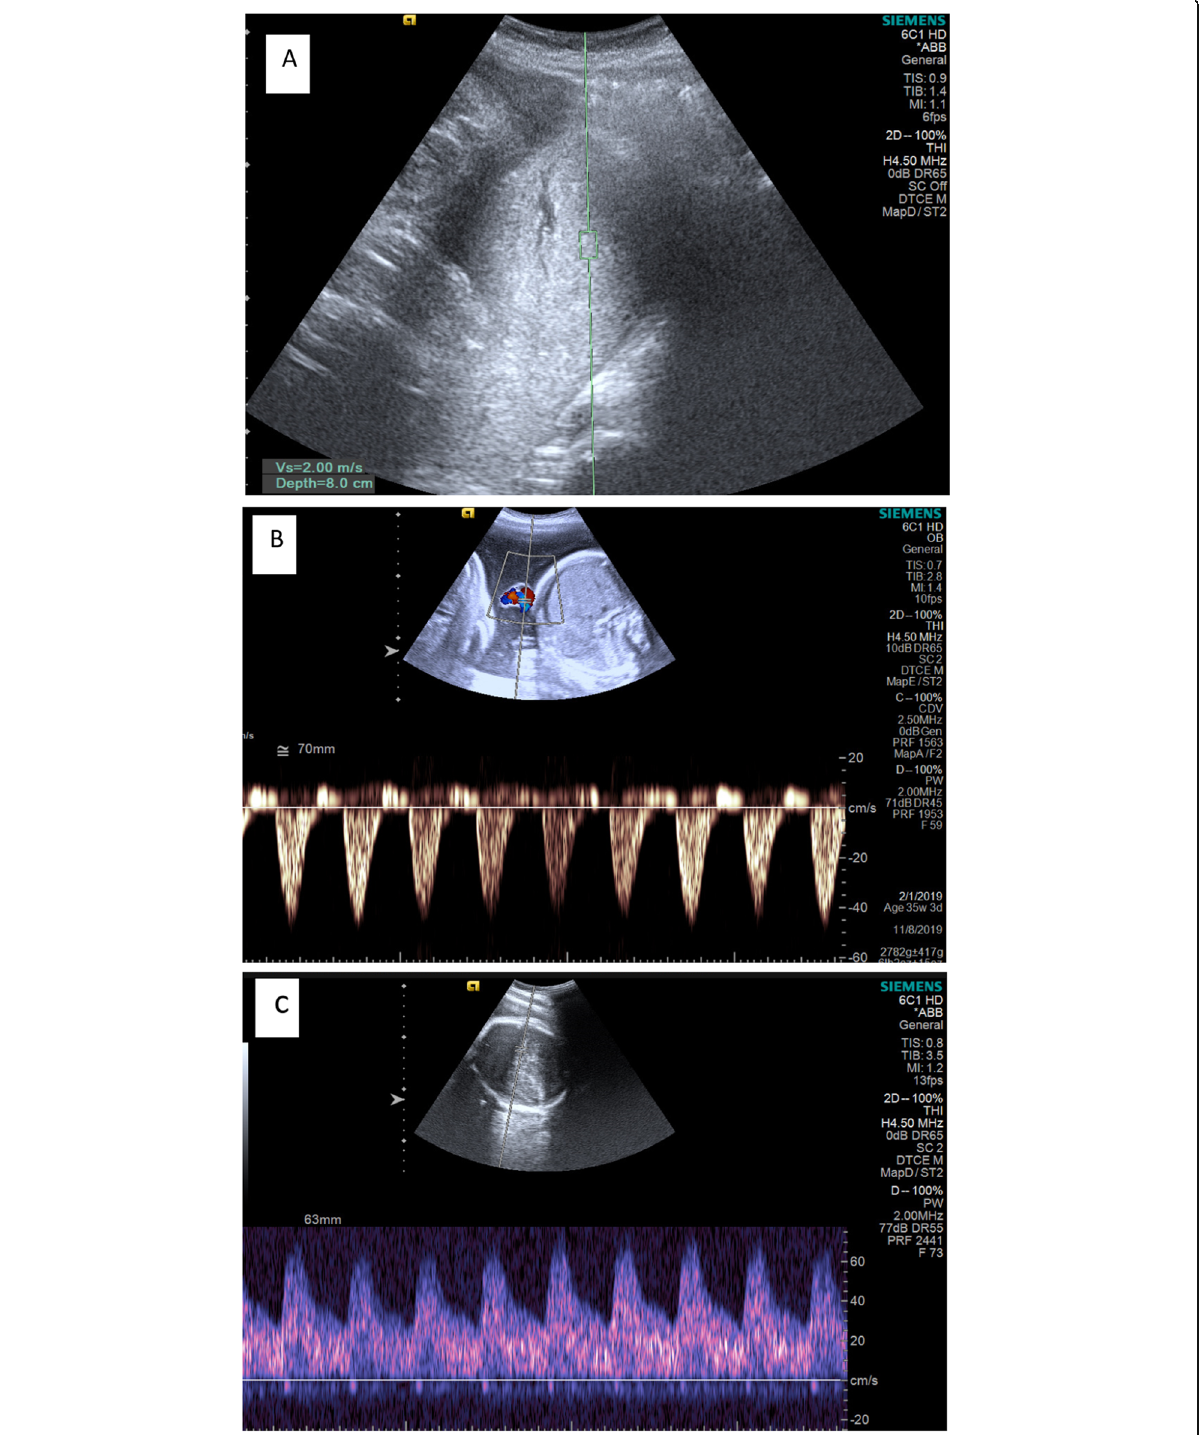
Fig. 6 Pregnancy with severe preeclampsia, gestational age 36 weeks, and estimated fetal. Weight 2.5 kg. a SWV = 2.00 m/s, depth 8 cm. b Reversed diastolic flow in the umbilical artery. c High diastolic flow in the middle cerebral artery (redistribution). In the current study, the SWV showed a strong correlation with the growth restriction and abnormal Doppler